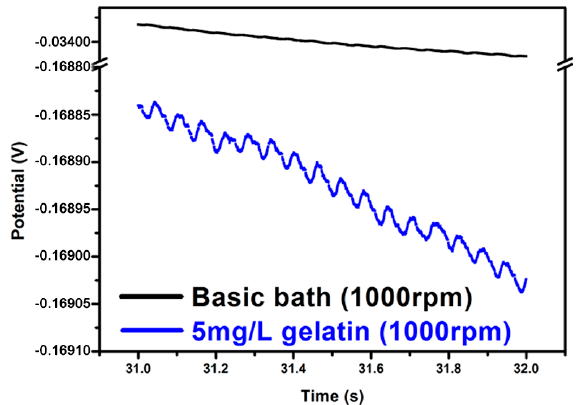
Figure 5. Magnification of the chronopotentiometry curves for a bath with gelatin and a basic bath. Both are stirred at 1000 rpm.